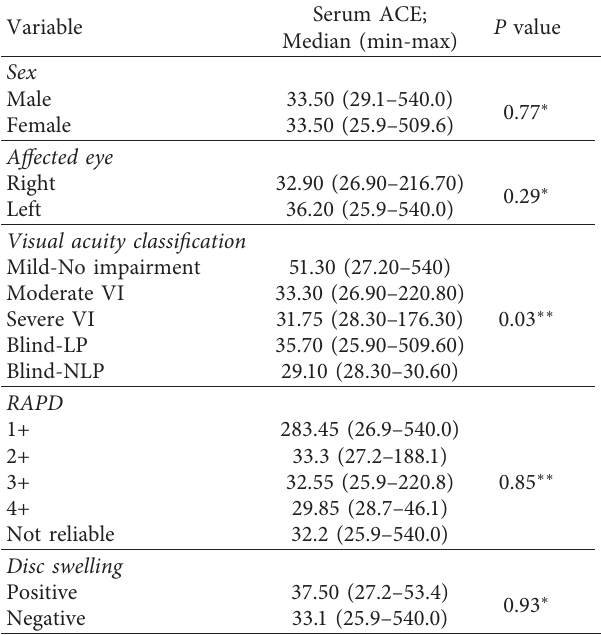
Table 2: Correlation of the clinical characteristics of idiopathic acute ON patients with serum ACE